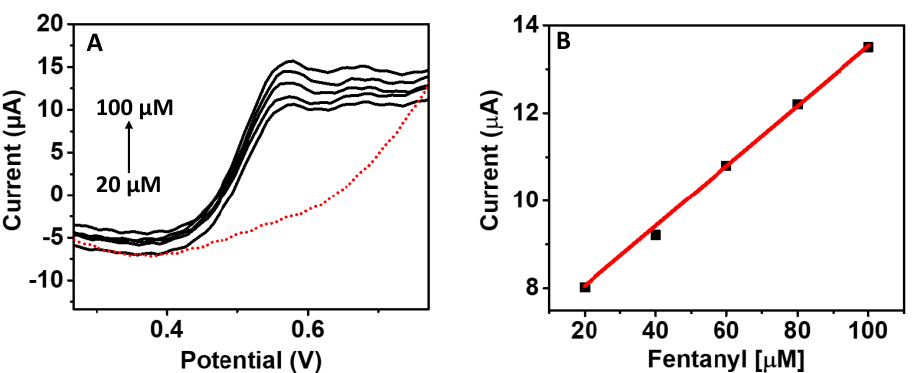
Figure 4. Application of microneedle sensor for fentanyl sensing in a real biofluid. ( A ) SWV response of increasing fentanyl (20–100 µ M) concentrations with each 20 µ M increase in the diluted serum samples ( B ) The corresponding current response from the fentanyl-detection curve ( A ). The SWV parameters were an equilibrium time of 5 s, potential range 0–0.9 V, E step 0.01 V, frequency 15 Hz; the experiments were performed at room temperature.